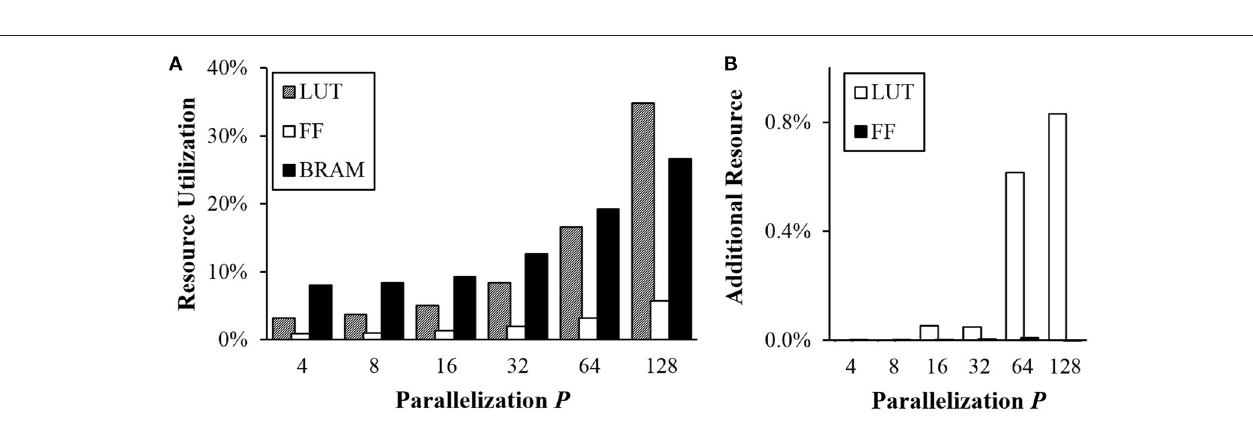
Per Second) when P = 128 at 100 MHz clock because it can cycle. The weight sparsity is assumed to be zero in this